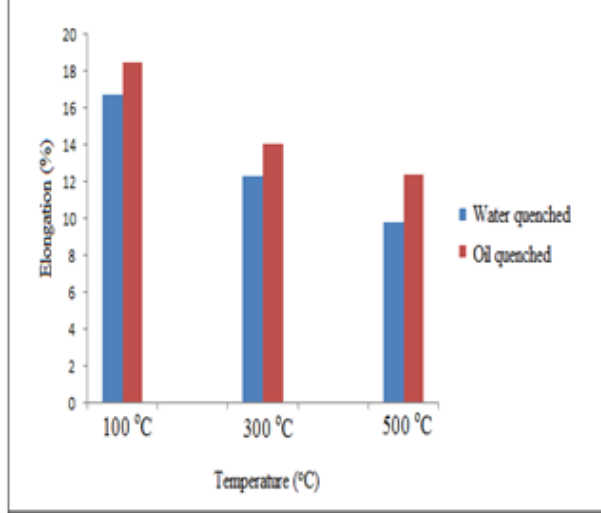
Fig. 3. Percentage elongation of heat treated and quenched mild steel